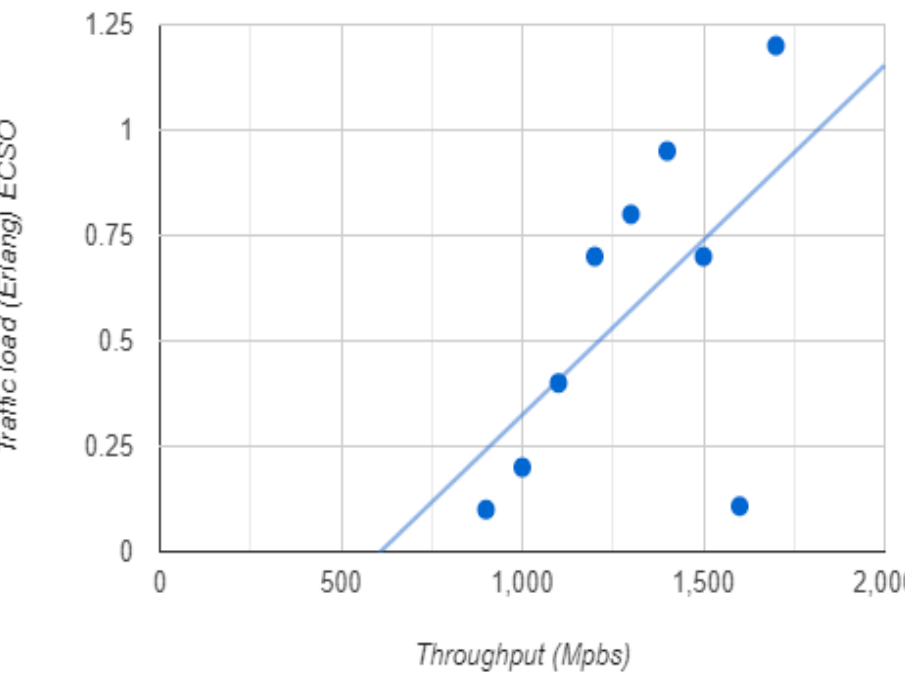
Figure 6. Traffic load against throughput.